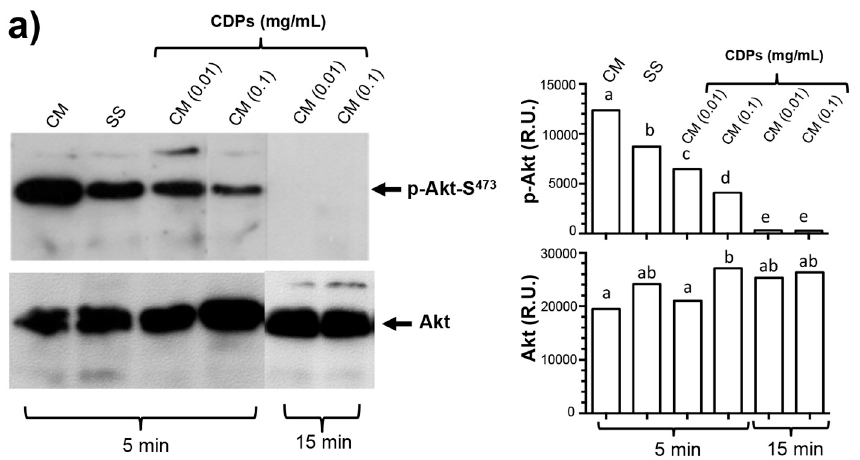
Figure 5 . Cont . Figure 5. Cont